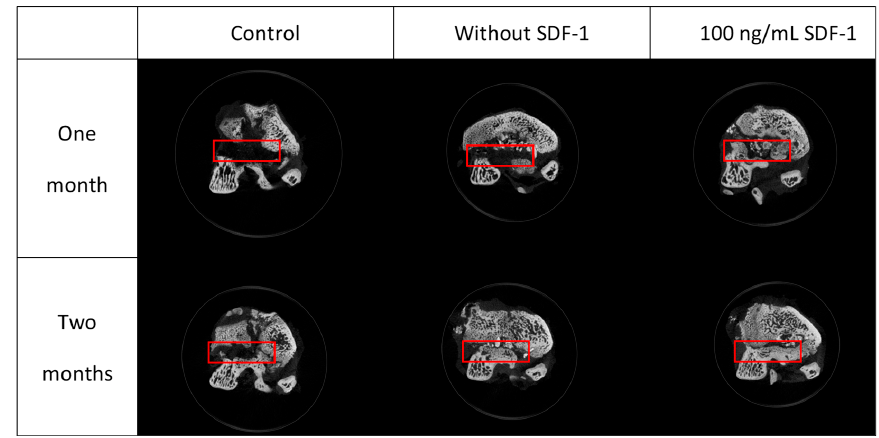
Figure 10. Micro-CT sections of specimens. Red rectangles indicate the site of the bone defect created by the drill. More bone ingrowth can be found in composite groups, especially the group with SDF-1.